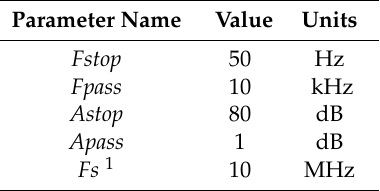
Table 4. Values of the design parameters implemented for the high-pass filtering algorithm.